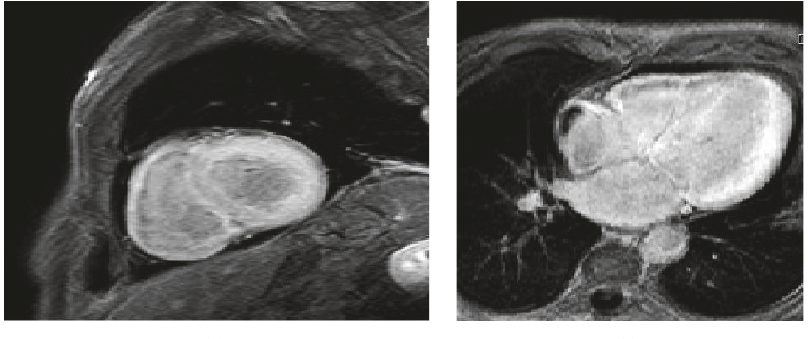
Figure 5: CMR short axis (a) and four-chamber view (b). LGE images showing diffuse, nonhomogenous myocardial enhancement involving both ventricles and atria. The pattern of enhancement is consistent with cardiac amyloidosis. Note the presence of a right atrial thrombus. Images courtesy of Professor Dr. Jan Bogaert, University Hospital